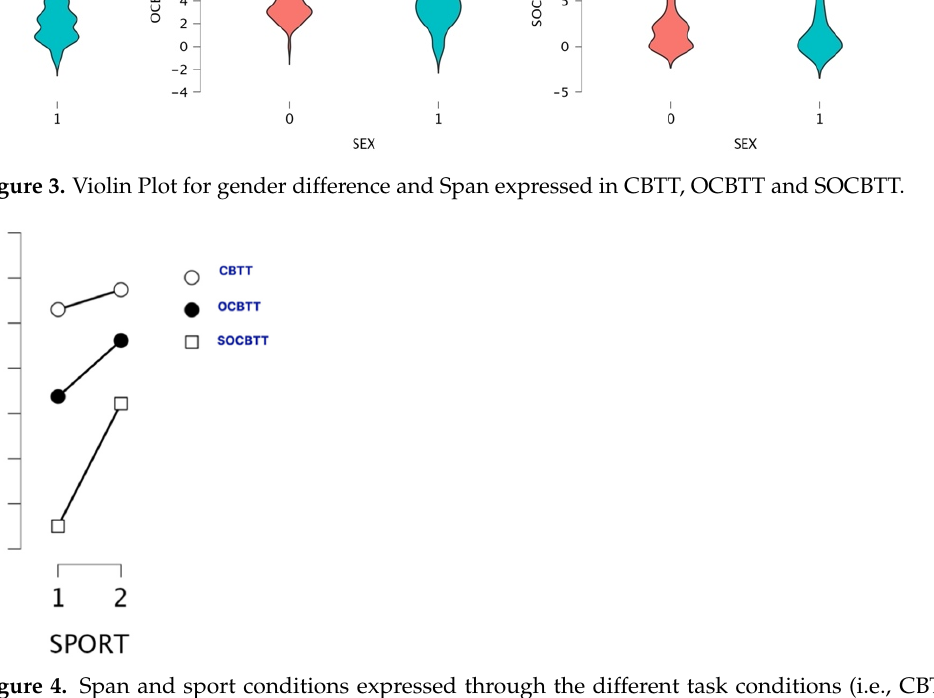
Figure 4. Span and sport conditions expressed through the different task conditions (i.e., CBTT; OCBTT and SOCBTT).